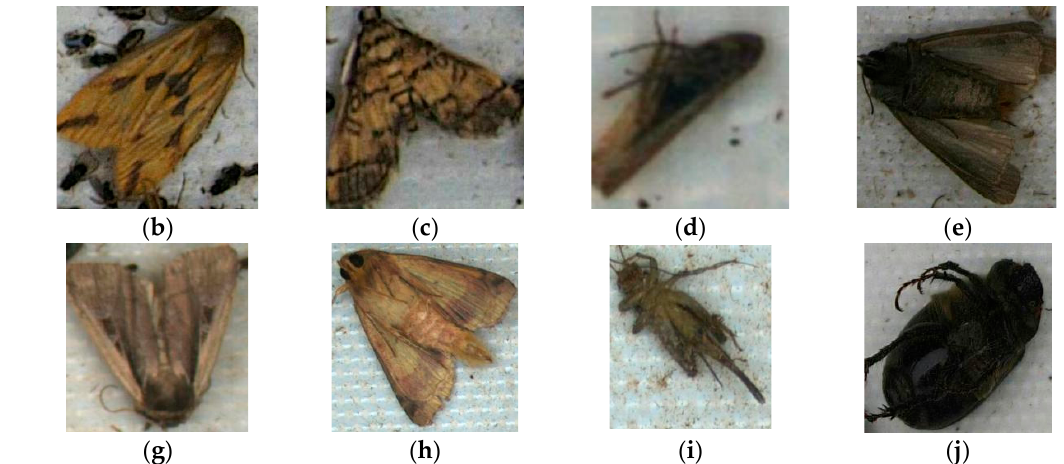
Figure 2. Examples of pest images: ( a ) C. suppressalis , ( b ) N. aenescens , ( c ) C. medinalis , (d) N. lugens , ( e ) A. ypsilon , ( f ) G. sp, ( g ) M. separata , ( h ) H. armigera , ( i ) Gryllidae, ( j ) H. diomphalia .